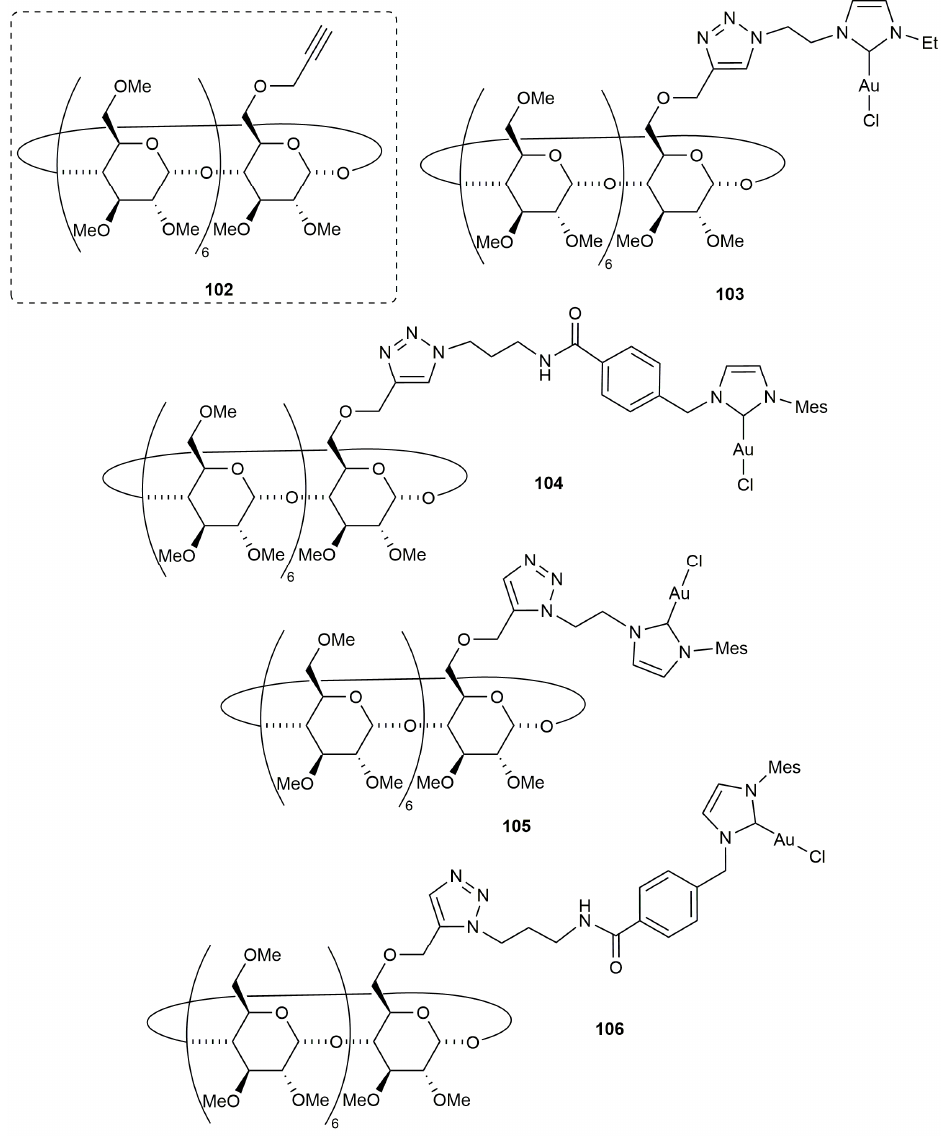
Figure 6. Structure of propargyl ether 102 and the NHC-Au(I) complexes 103 – 106 . Following a related approach, the NHC-gold(I) derivatives 108 and 109 , containing a 1,4-disubstituted triazole linker, were additionally accessed from the β -CD-derived azide 107 through initial CuAAC coupling with the corresponding alkyne-substituted imidazolium salt, and subsequent coordination via Ag-Au transmetallation (Figure 7) [102]. Complexes 103 – 106 , 108, and 109 catalyzed the cycloisomerization of the α -hydroxyallene 100 in water and in the absence of a silver additive, all of them showing effectiveness and recyclability comparable to that of 99a .